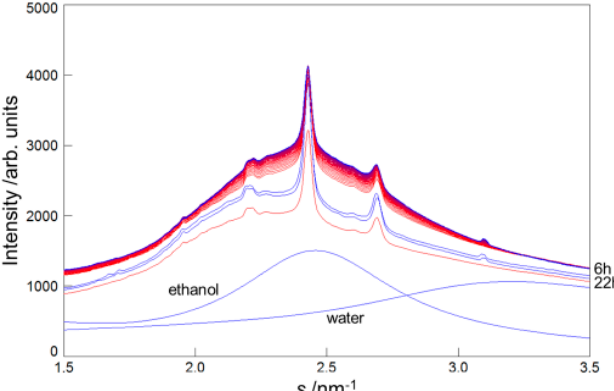
Figure 1. Wide-angle X-ray diffraction profiles in human stratum corneum for the sample #E1 when ethanol was applied to the stratum corneum with a water content of about 25 wt %. The profiles changed from the red to the blue curve over time. The blue profiles at 6 h and 22 h show those obtained by removing ethanol from the treated stratum corneum, as mentioned in the text. Profiles of ethanol and water are shown for convenience in a relative scale.